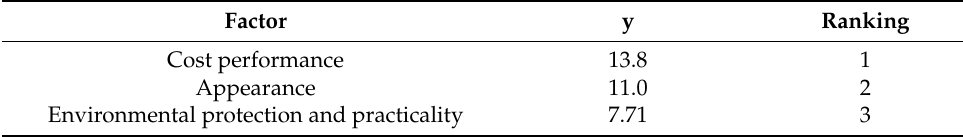
Table 3. The importance ranking of three factors in Question 4. Factor